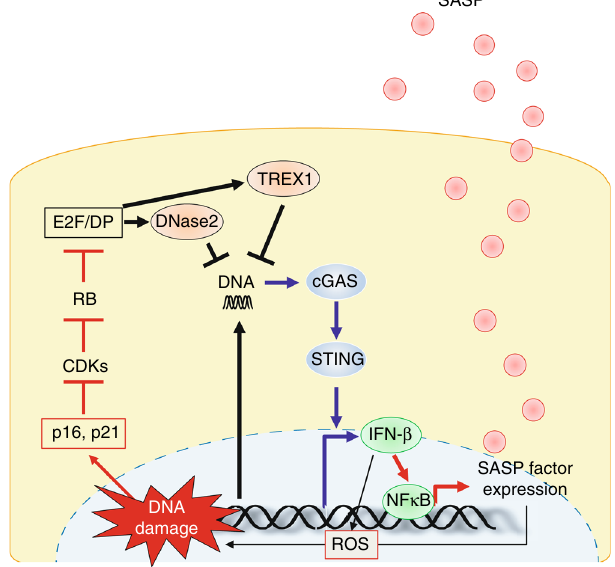
Fig. 7 A model of SASP induction. The expression of DNase2 and TREX1 is maintained, at least partly, through E2F in pre-senescent cells, and senescence-associated reduction of E2F transcriptional activity results in cytoplasmic accumulation of nuclear DNA, leading to an aberrant activation of cytoplasmic DNA sensing pathway, which in turn provoke SASP through IFN- β pathway in senescent